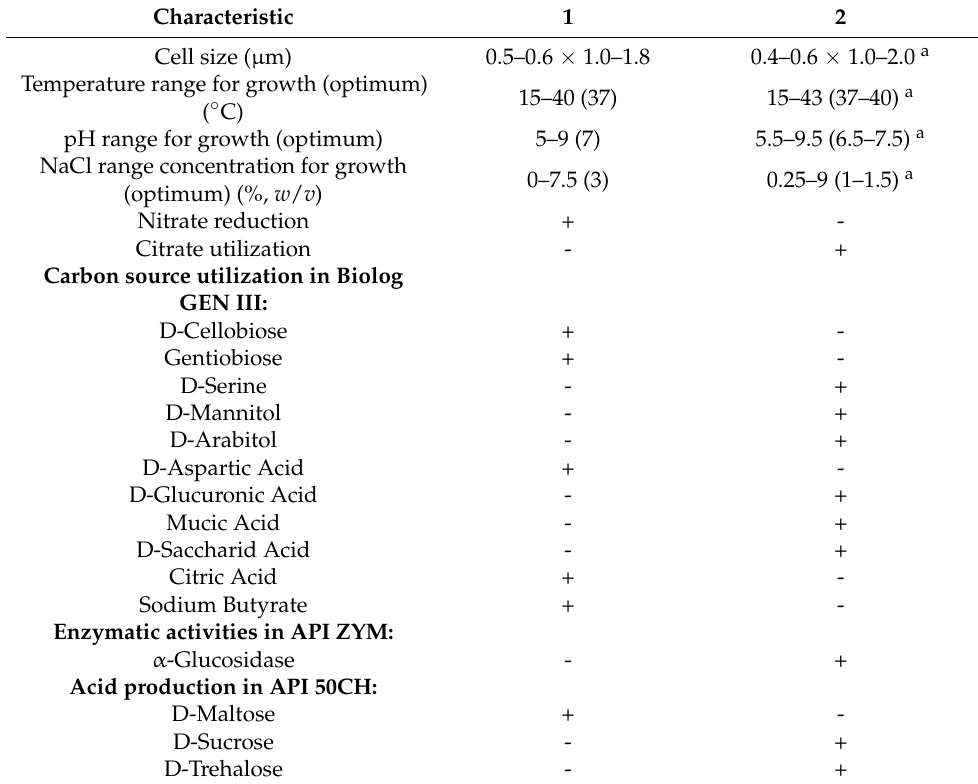
Table 3. Differential phenotypic features of strain D7 T in comparison to those of the closest related species of the genus Marinobacterium